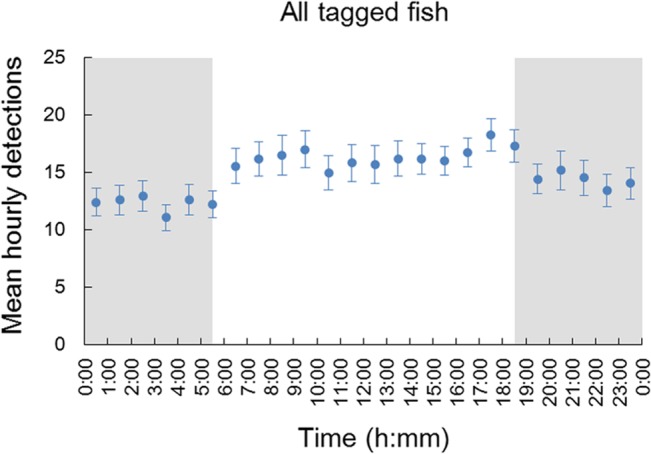
Mean hourly detections (± SE) of six tagged fish.Background color indicates day (white) or night (grey) based on the local sunrise and sunset time.